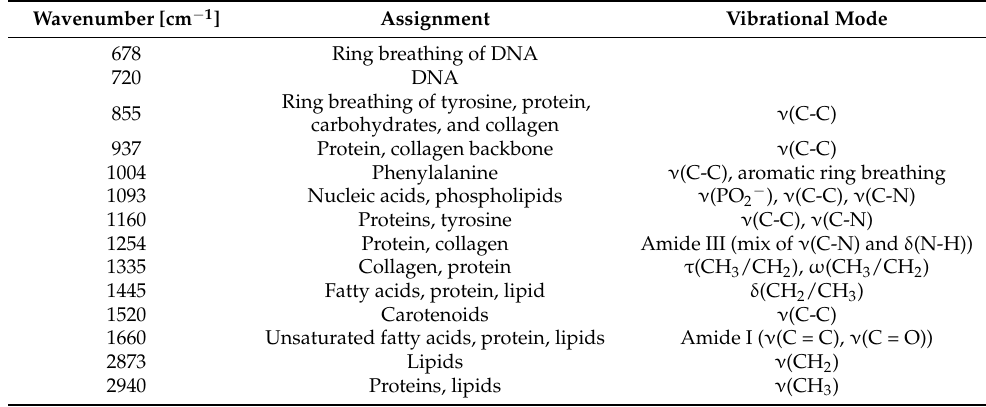
Table 2. Overview of Raman bands, corresponding assignment and vibrational modes of pituitary gland and pituitary adenomas